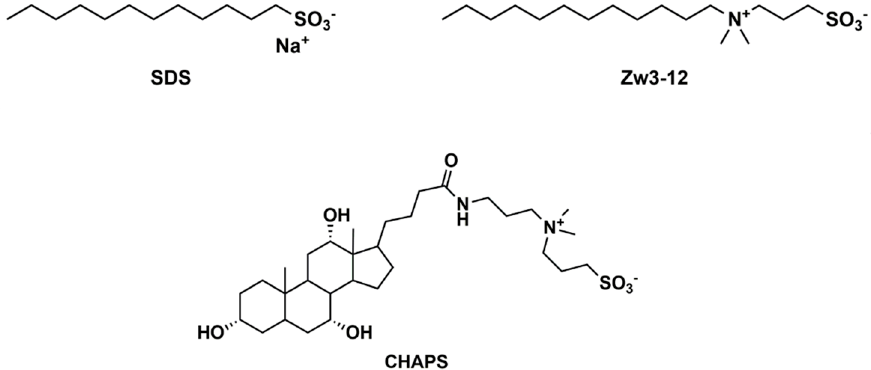
Figure 2. The chemical structures of the surfactants used in this study: SDS (sodium dodecyl sulfate); Zw3-12 ( n -dodecyl- N , N -dimethyl-3-ammonio-1-propanesulfonate); and CHAPS (3-[(3-chol-